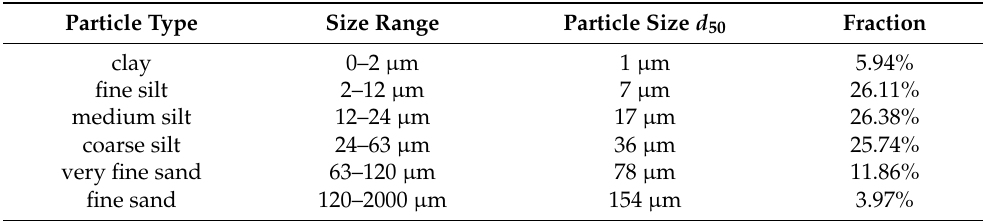
Table 1. Particle types, size ranges, particle sizes d 50 and their fractions for the sediment core samples averaged over stations S9–S13 of the Rove Canal (according to